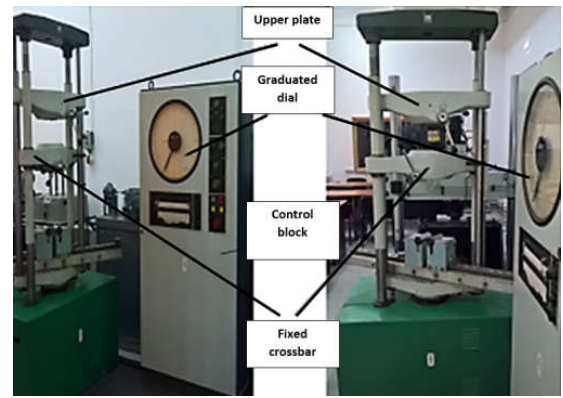
Figure 13. Final model of the orthopaedic prosthesis with morcellated bone graft and reconstructive mesh.